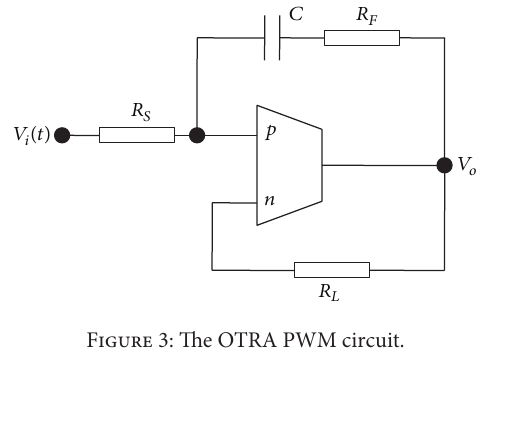
F 3: e OTRA PWM circuit.